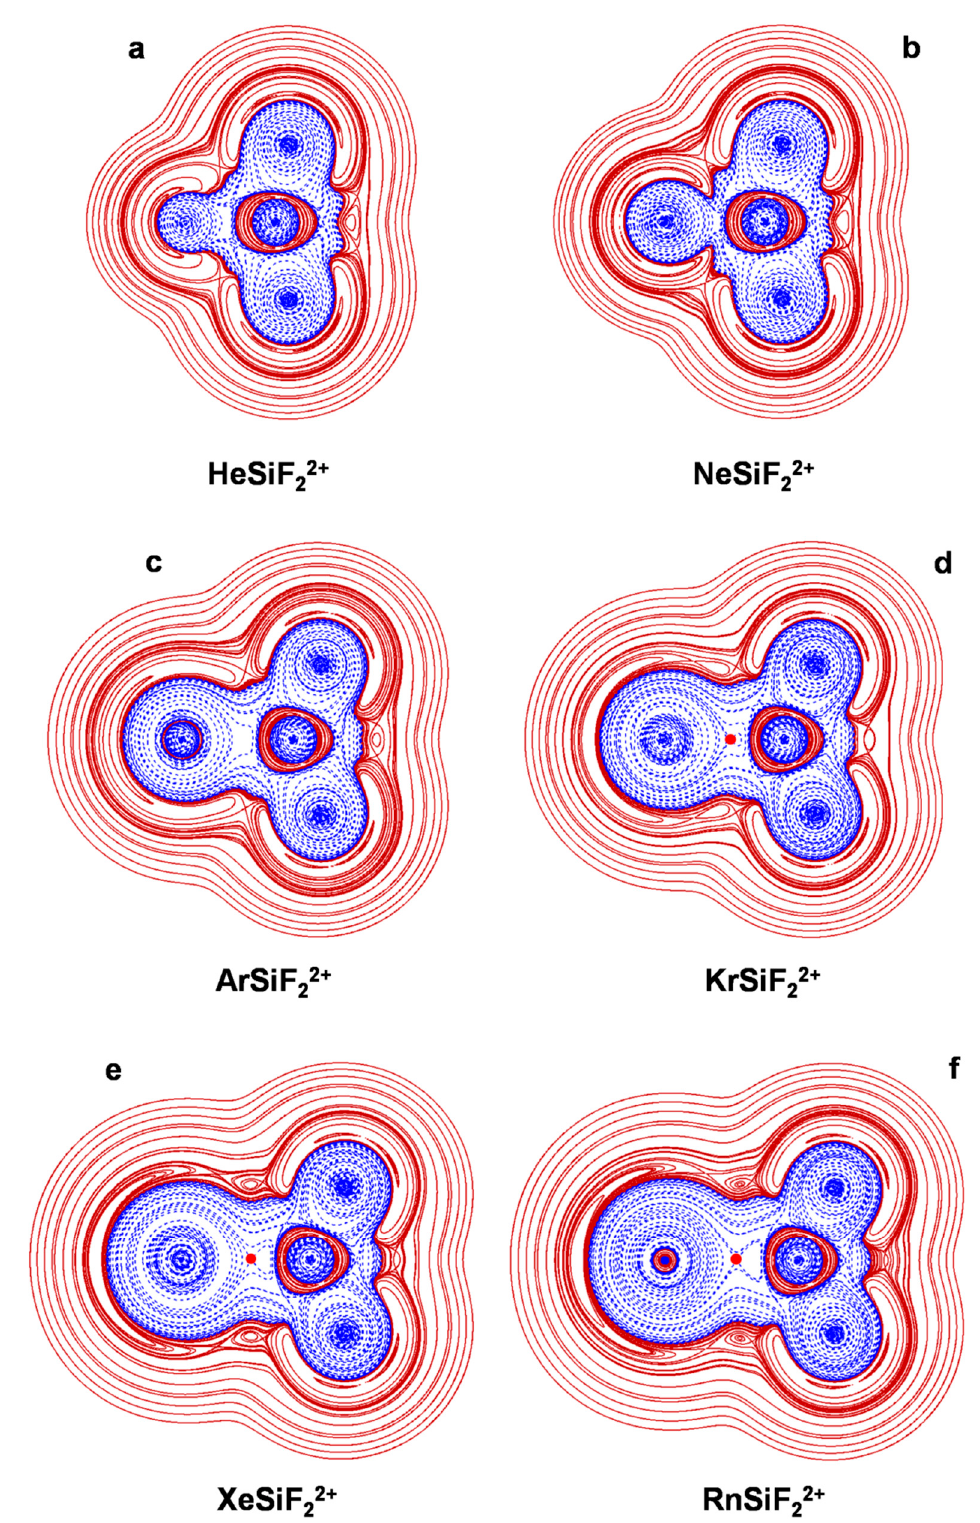
Figure 6. 2D plots of H ( r ) in the symmetry plane of ( a ) HeSiF 22+ ; ( b ) NeSiF 22+ ; ( c ) ArSiF 22+ ; ( d ) KrSiF 22+ ; ( e ) XeSiF 22+ ; ( f ) RnSiF 22+ (solid/brown and dashed/blue lines correspond, respectively, to positive and negative values). The red dots represent the HCPs.